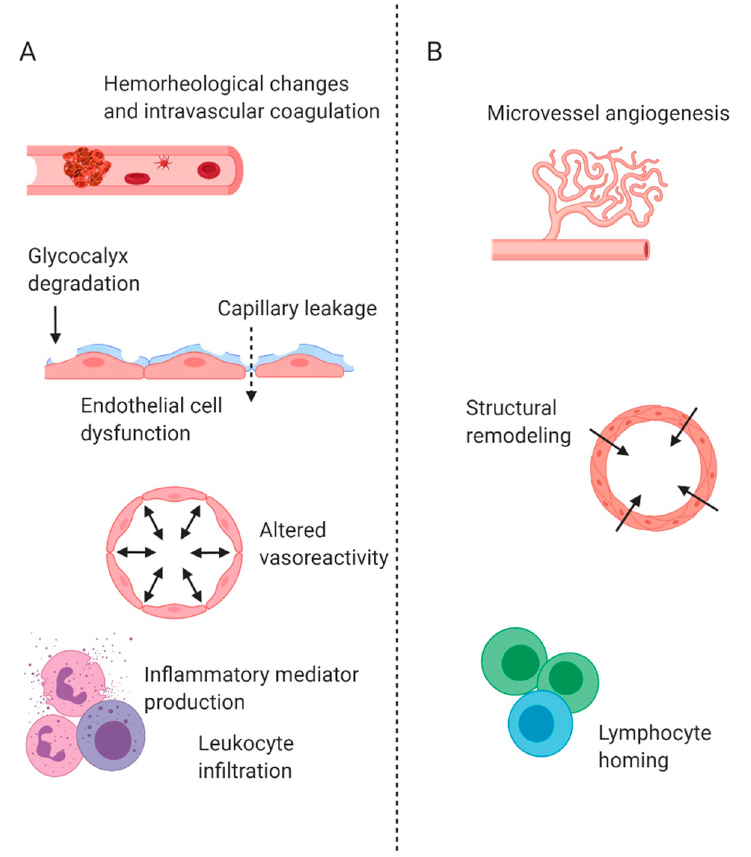
Figure 2. Microcirculatory changes during ( A ) acute and ( B ) chronic inflammation of the intestine. ( A ) During acute inflammation, various microcirculatory changes occur. Hemorheological changes and intravascular coagulation impact blood flow. Degradation of the glycocalyx and capillary leakage contribute to endothelial cell dysfunction. Microvessels may also experience altered vasoreactivity. In addition, leukocytes become highly activated and may infiltrate into tissues and produce high levels of inflammatory mediators. ( B ) During chronic inflammation, additional microcirculatory changes may occur. Microvessel angiogenesis and structural remodeling impact vessel structures. Lymphocyte homing occurs as the adaptive immune system responds.